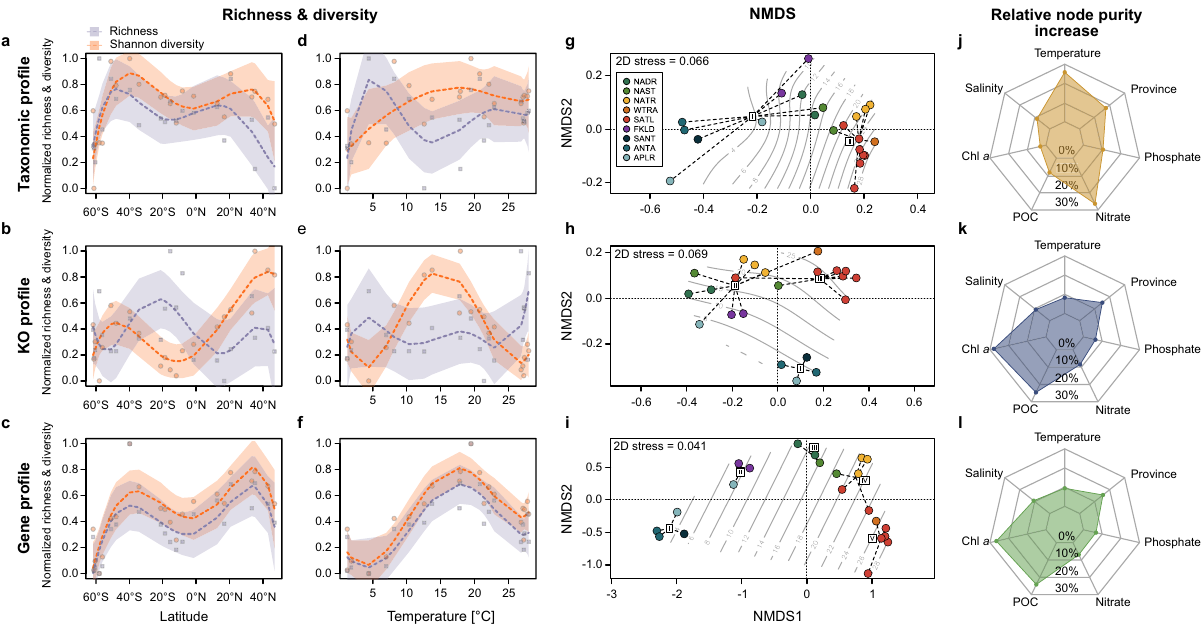
Fig. 2 Taxonomic and functional diversity features of the AOM and related to in situ temperature. a – c Normalized richness and diversity of taxonomic, KO, and gene pro fi le of the AOM in relationship to latitude. d – f Relationship of normalized taxonomic, KO, and gene richness and diversity with temperature. Shading indicates the 95% con fi dence interval of the regression. g – i NMDS of Bray – Curtis dissimilarity of taxonomic, KO, and gene pro fi les. Isoclines approximate ambient temperature. Clusters were determined using Ward.D2 clustering and an optimal number of clusters was determined using the silhouette coef fi cient. j – l relative increase of node purity of environmental variables in observed clusters of taxonomic and functional pro fi les, determined by random forest models (number of trees = models based on hydrographic and biogeochemical properties of stations. The models explained 61% of the variance in the taxonomic pro fi le and 36.5% and 35.8% of the variance in the KO and gene pro fi les, respectively. Taxonomic cluster (tC) I of the taxonomic pro fi le encompasses stations from the Antarctic to subtropical regions whereas stations from tCII are located in the subtropics and tropics between 40°S and 34°N (Fig. 2g). Ambient temperature, annual mean nitrate concentration, and province af fi liation were the most in fl uential factors explaining the separation of the two clusters at approximately 18 °C and nitrate concentrations of 4 and 0.8 µM in the South and North Atlantic, respectively (Fig. 2j). This illustrates the compositional difference between the subtropical gyres and temperate and (sub)antarctic regions and the strong impact of temperature on the composition of the near-surface AOM, while biogeochemical and nutrient properties affected the cluster separation only to a lesser degree.